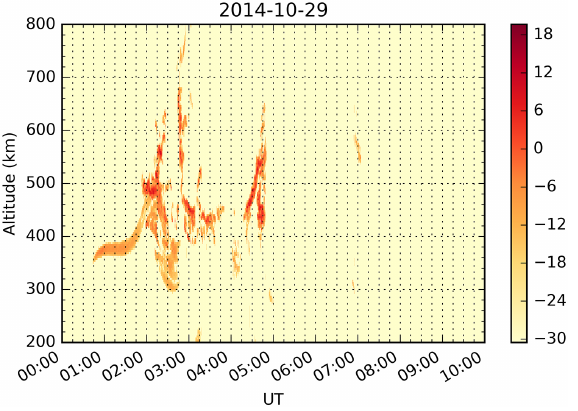
Figure 4. A range–time–intensity plot from 29 October 2014 show- ing signal-to-noise in decibels as a function of altitude and Univer- sal Time. During this night bottom-type, bottomside, and topside ESF irregularities are visible.